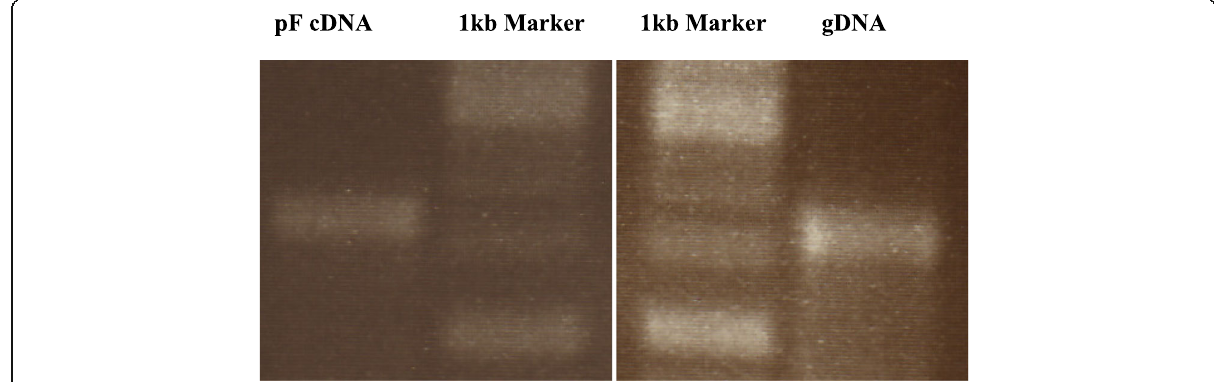
Fig. 2 The PCR products analysis by ethidium bromide-stained gel of the amplified products (slightly above 1500 bp) using S. ratti pF cDNA and gDNA